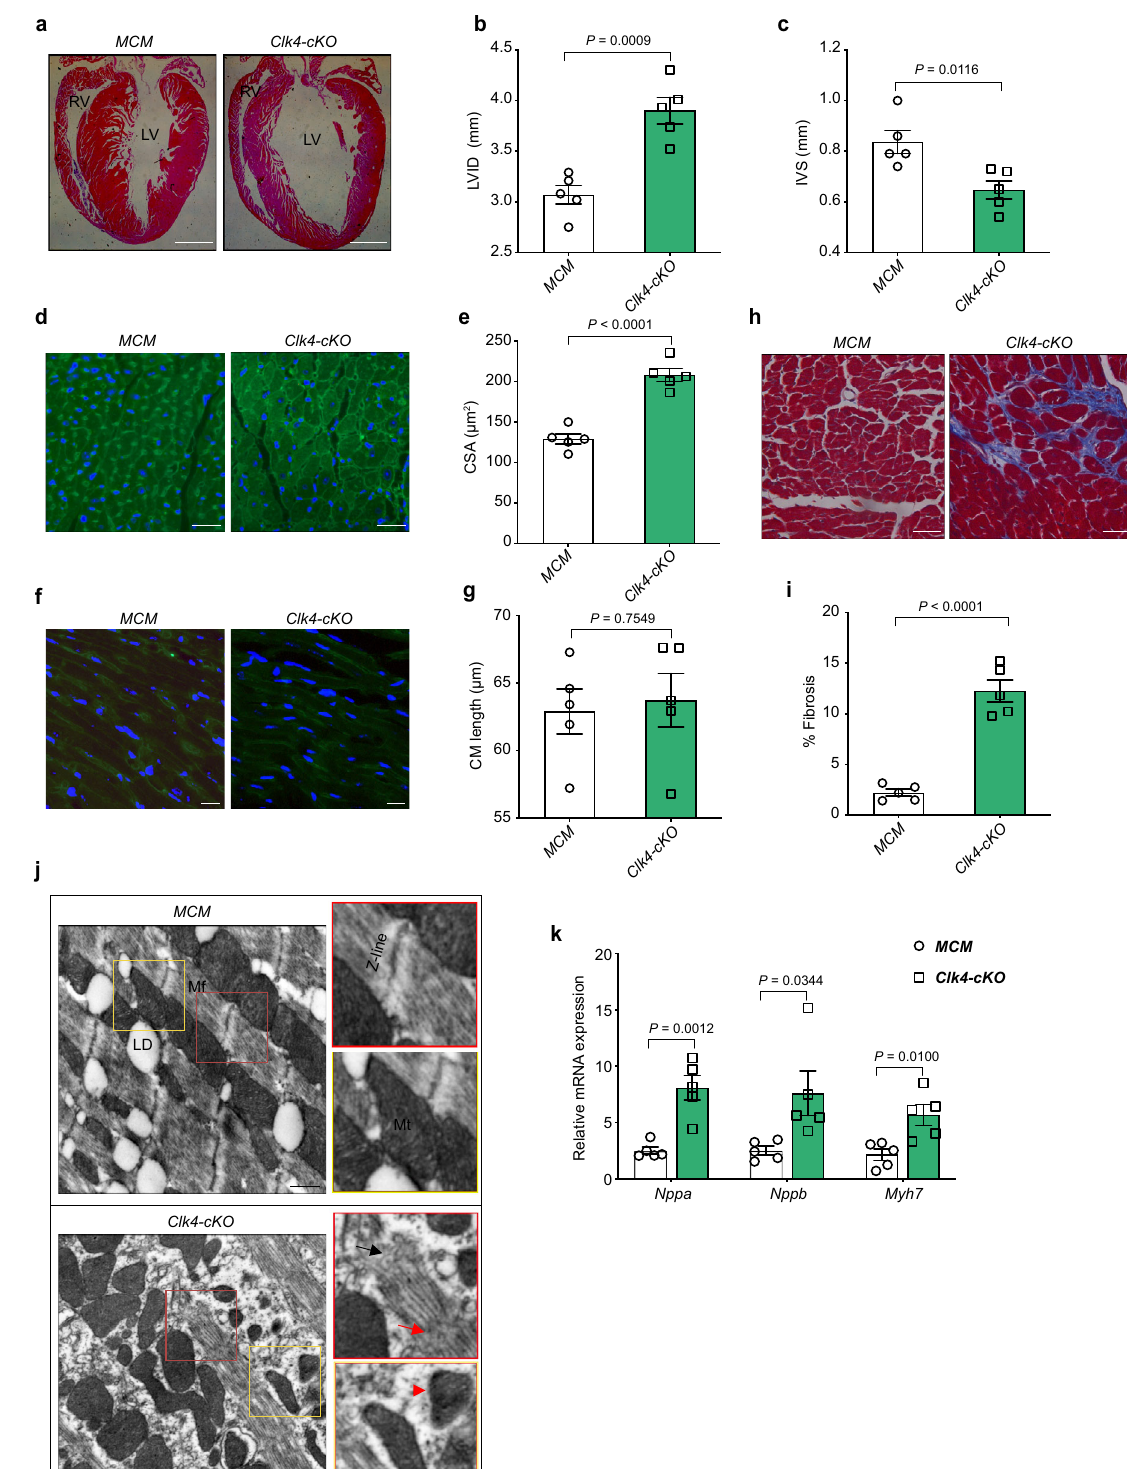
Fig. 3 | Histological and molecular characterization of Clk4 -cKO mice. a H&E- stained heart sections from MCM control and Clk4 -cKO hearts. Scale bar: 1mm. b , c Summary data for LV internal diameter (LVID) and interventricular septum (IVS) thickness. d , e WGA staining and quanti fi cation of cardiomyocyte cross- sectional area. Scale bar: 50 μ m. f , g WGA staining, and quanti fi cation of cardio- myocyte length. Scale bar: 25 μ m. h , i Masson ’ s trichrome staining of heart sec- tions and quanti fi cation of myocardial fi brosis. Scale bar: 50 μ m. j Transmission electron micrographs comparing control and Clk4 -cKO hearts. Mt